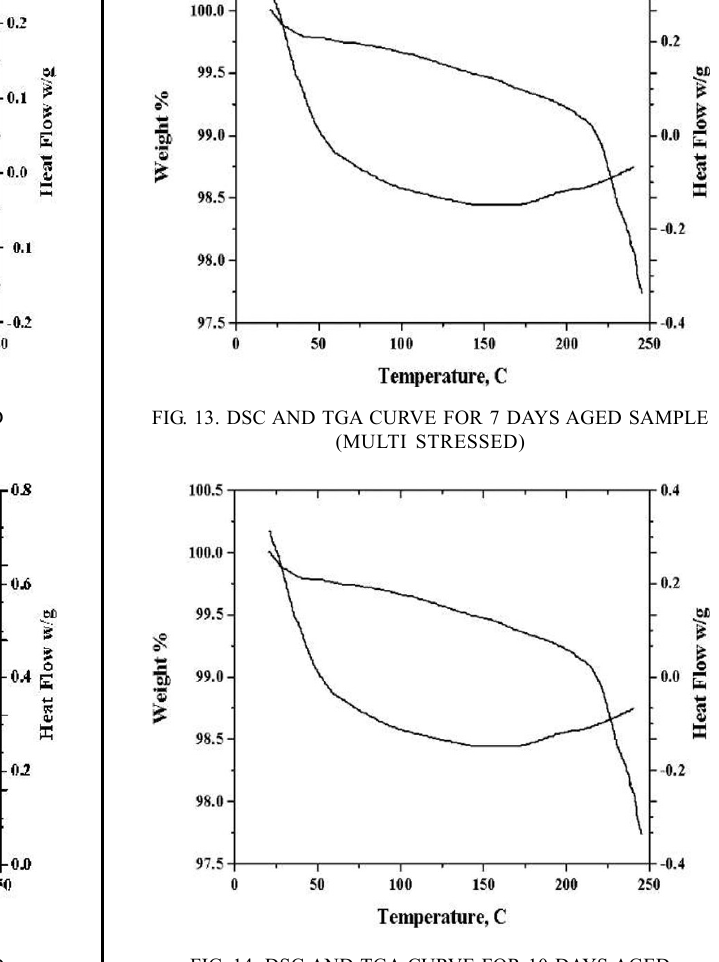
FIG. 12. DSC & TGA CURVE 5 MULTI STRESSED